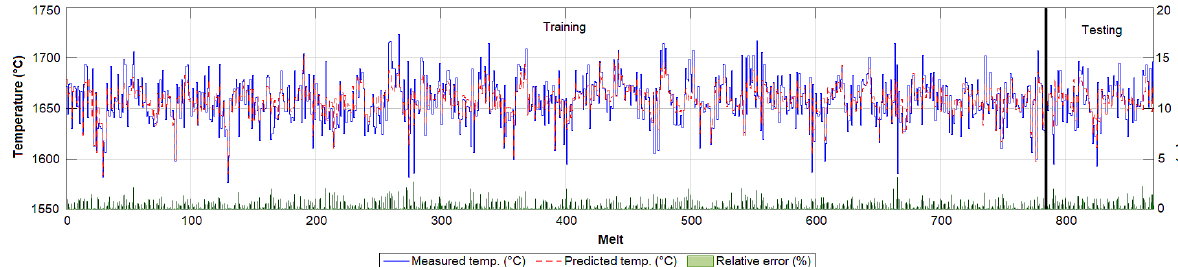
Figure 5. Prediction of endpoint melt temperature by SVR model with the polynomial